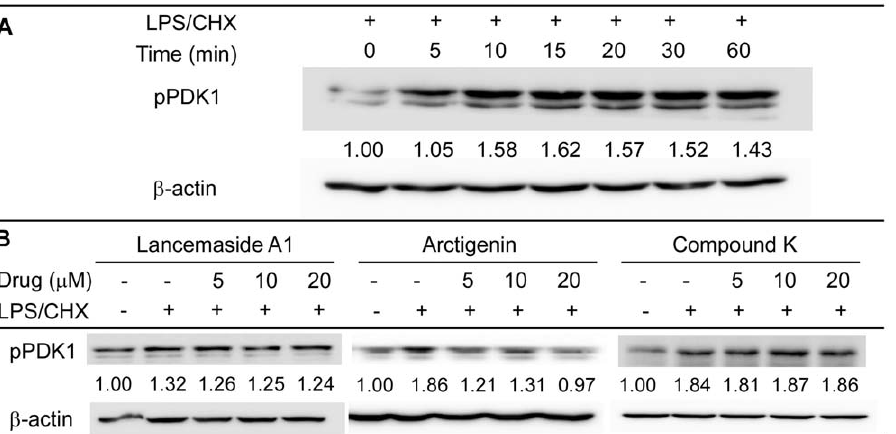
Figure 5. Examining the effects of the screened compounds on PDK1 phosphorylation. ( A ) A time course of PDK1 phosphorylation (pPDK) was performed to determine the optimal time point for maximum detection of pPDK1, which was achieved within 10 minutes of LPS/CHX treatment. ( B ) Cell lysates of Tat-expressing CHME5 cells treated for 20 minutes in the presence and absence of LPS/CHX. pPDK1 data were normalized to b -actin and the mean values are shown below the blot. Data are representative from two independent studies.